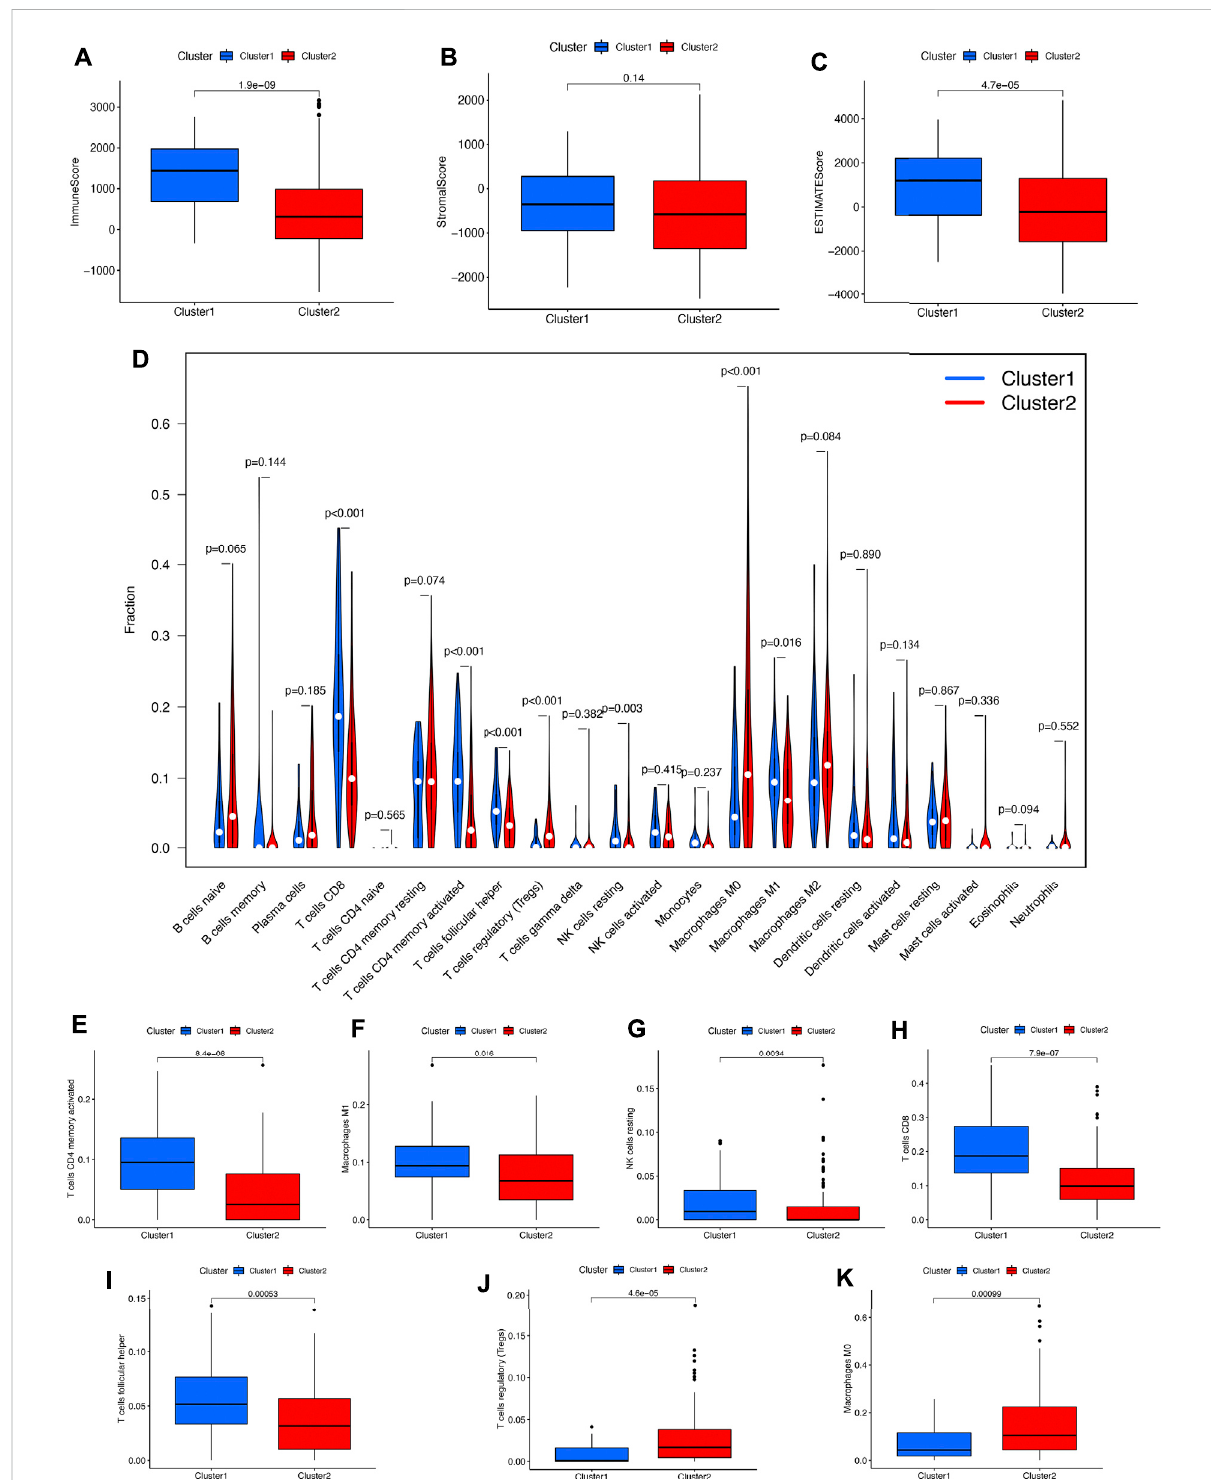
FIGURE 4 Clustercorrelated withdifferentimmunein fi ltrations inbladdercancer. (A – C) Cluster1correlatedwithhighImmunoscoreand ESTIMATEScore compared withthoseincluster2inbladdercancer. (D) Thedifferenceoftheabundanceof22immune cellsinthetwoclusters. (E – K) The in fi ltrating levels of CD4 memory-activated T cells, macrophage M1, NK resting cells, CD8 T cells, follicular helper T cells, Tregs, and macrophage M0 in two